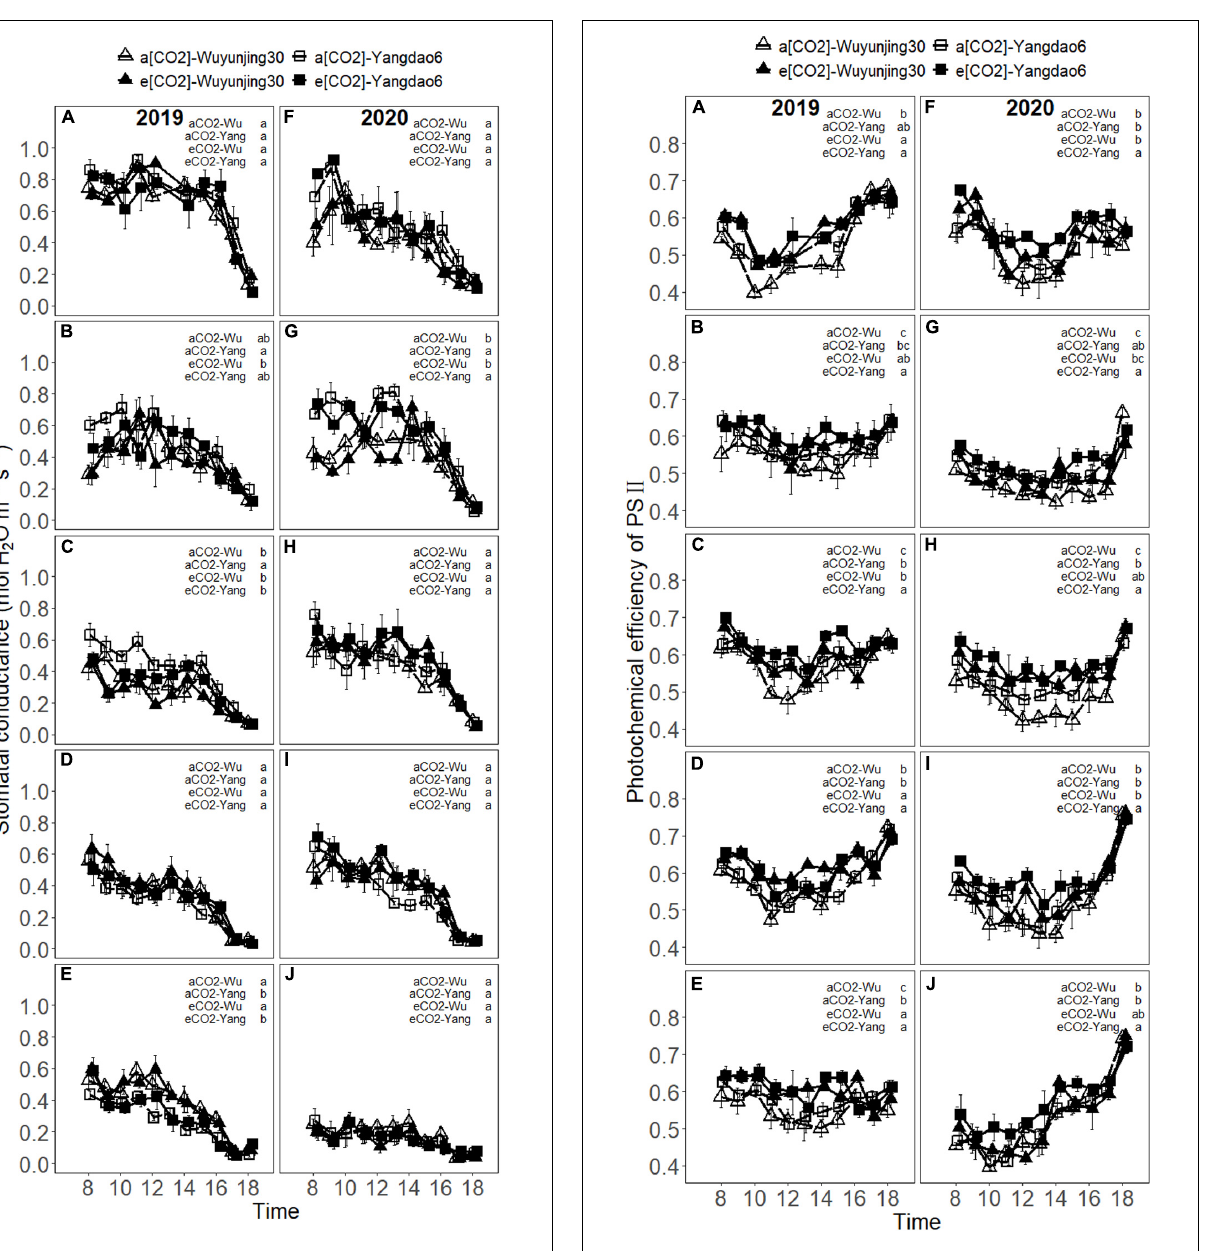
FIGURE 4 | Diurnal variations in photochemical efficiency of PSII (F v (cid:48) /F m (cid:48) ) of rice cultivar Wuyunjing30 and Yangdao6 grown at ambient and elevated (CO 2 ) at jointing (A,F) , booting (B,G) , heading (C,H) , grain-filling (D,I), and maturity (E,J) stages in 2019 and 2020. Values were expressed as means ± standard errors form. Values of F v (cid:48) /F m (cid:48) under four (CO 2 ) × cultivar treatments at 13 p.m. at jointing stage in 2019 were deleted because of the abnormal values found by examination. Statistical analyses of multiple comparisons for five growing stages in 2 years were shown in each panels of the figure in the form of lowercase